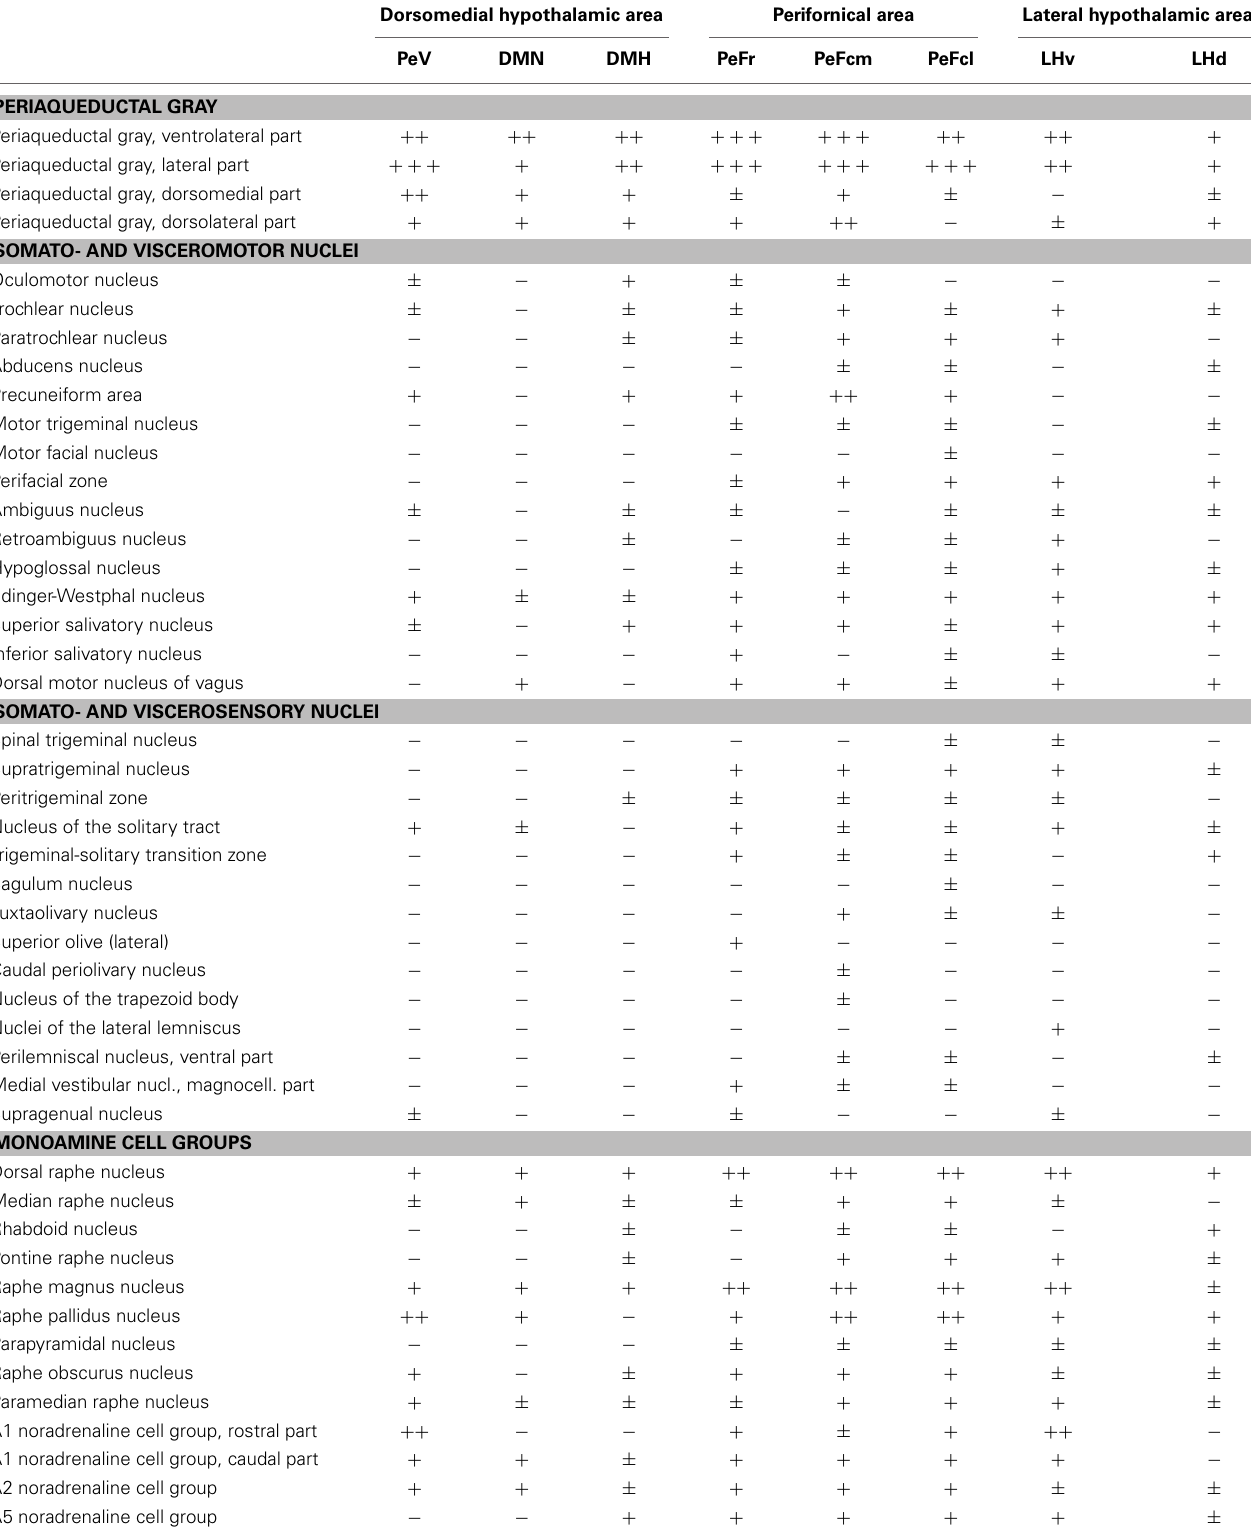
Table 1 | Relative density of BDA-labeled fibers in the lower brainstem after tracer injections into different subregions of the dorsolateral